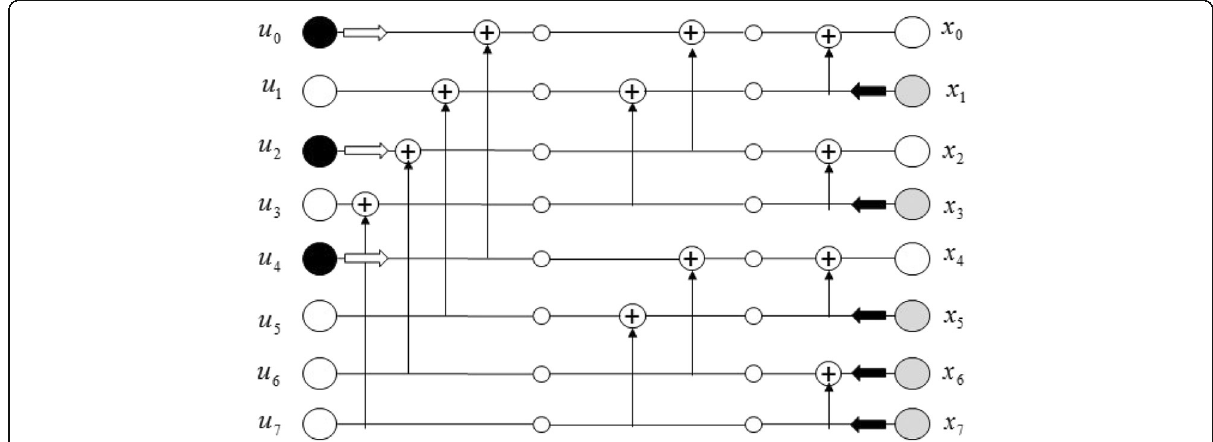
Fig. 1 SPC encoding diagram with N = 8 and A = {1, 3, 5, 6, 7}: The encoding direction is from bottom to top. The encoding process for information bits starts from right to left. Then, the encoding process for frozen bits is from left to right. The gray circles on the rightmost represent the information bits, and the black circles on the leftmost represent the frozen bits. The black arrow on the right represents the computing direction of the information bits. The black arrow on the left represents the computing direction of the frozen bits. The final outputs of the encoding are the value of the rightmost black